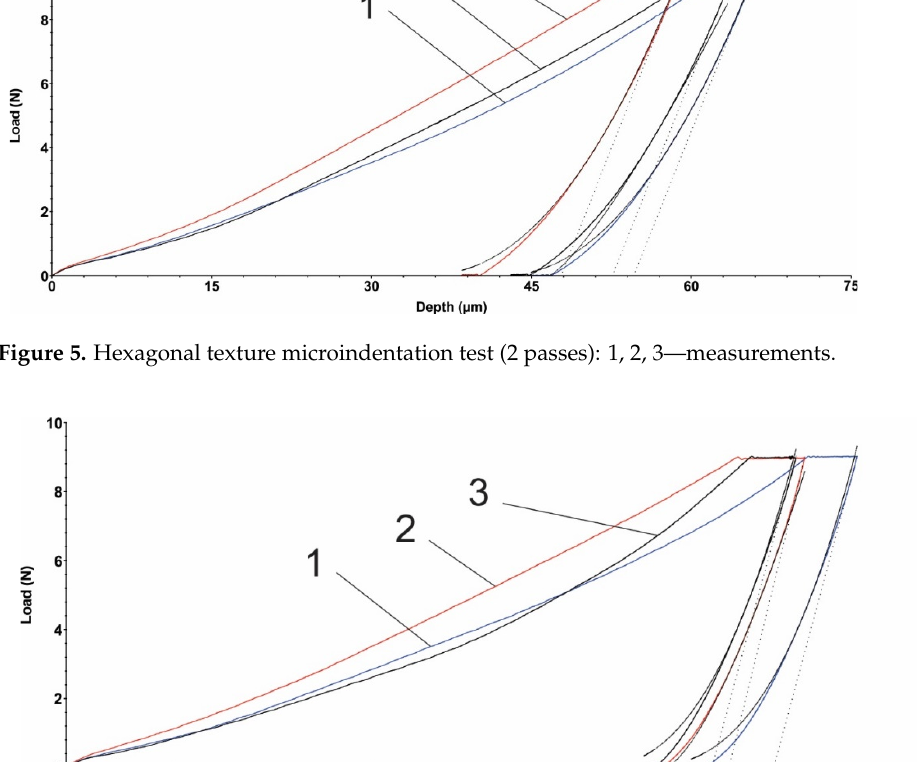
Figure 8. Square texture microindentation test (4 passes): 1, 2, 3—measurements. Table 7. Hexagonal (H) texture values. Test Num- ber